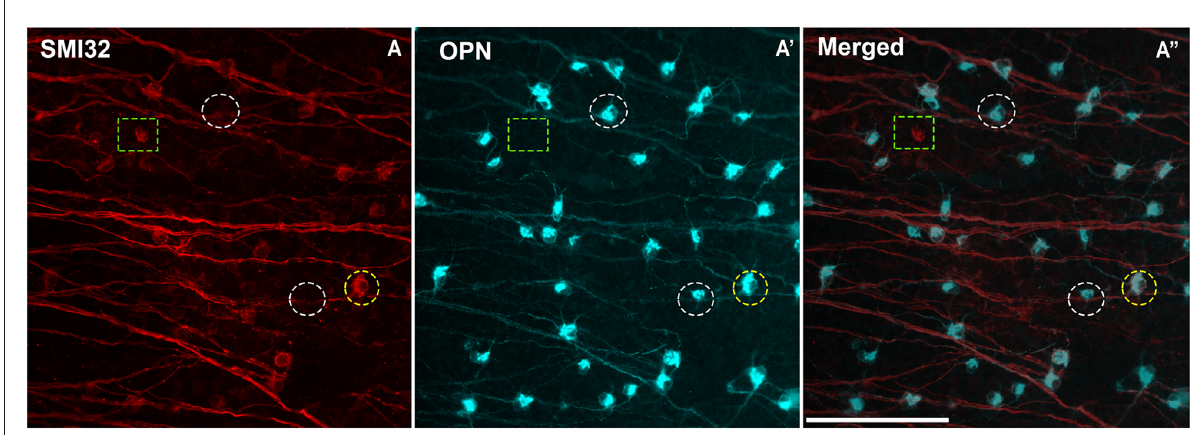
FIGURE3 Colocalization between the two panmarkers of α RGCs: SMI32 and OPN. (A–A”) Representative micrographs from the temporal region of the mouse retina immunolabeled with OPN and SMI32. (A) Expression of SMI32 (in red) is located in α RGC axon, dendrites, and soma. (A’) Expression of the OPN (in blue) is located weakly in axons and dendrites but strongly in the somas of α RGCs. (A”) Superimposed and merged image with the SMI32 (in red) and OPN (in blue). Discontinuous white circles in (A–A”) represent a SMI32 − OPN + α RGC, discontinuous green rectangles in (A–A”) represent a SMI32 + OPN − α RGC and discontinuous yellow circles in (A,A”) represent SMI32 + OPN + α RGC. Scale bar: 100 µ